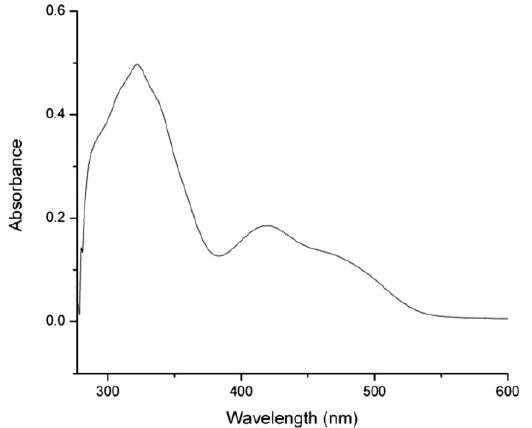
Figure 20. UV-visible absorption spectrum of DOPEQ in chloroform. Reprinted from Ref. [235] Copyright 2010, Wiley.